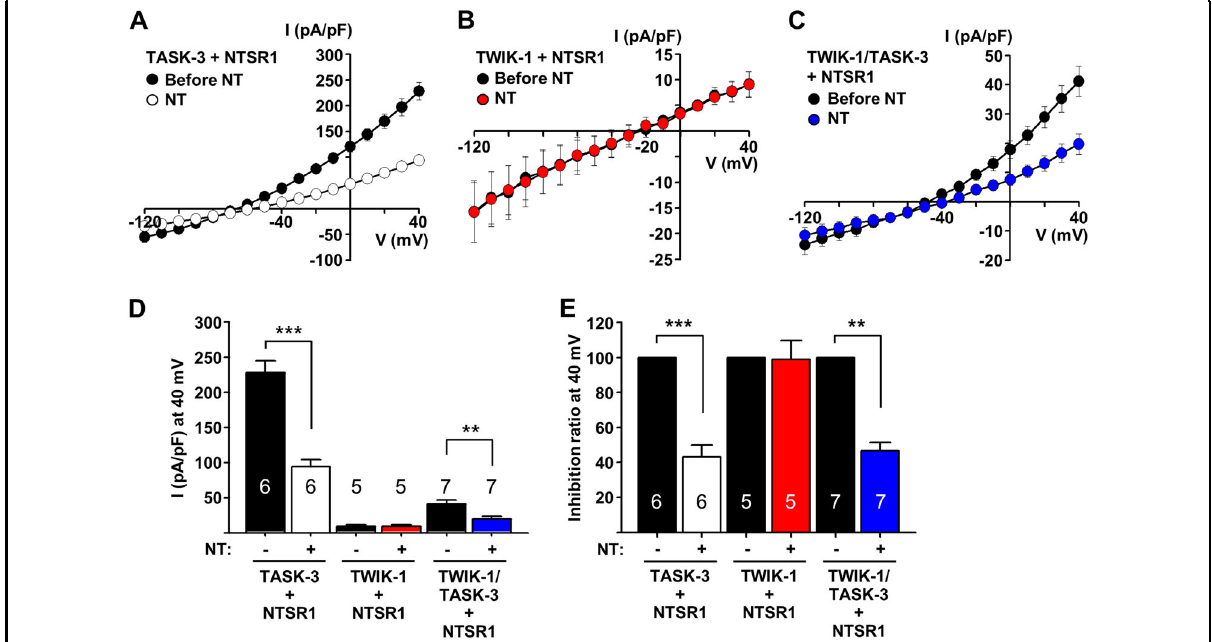
Fig. 5 The activity of the TWIK-1/TASK-3 concatenated chimera is inhibited by NT – NTSR1 signaling. a – c Averaged I – V relationships in COS-7 cells transfected with TASK-3 and NTSR1 a , TWIK-1 and NTSR1 b , or the TASK-3/TWIK-1 concatenated channel and NTSR1 c , measured before and after the application of 10 μ M neurotensin (NT) under a whole-cell con fi guration. d Summary bar graph showing normalized current density (as in a – c ) at + 40 mV. All values are means ± SEM (** P < 0.01 and *** P < 0.001). e Summary bar graph showing the inhibition ratio by NT application. All values are means ± SEM (** P < 0.01 and *** P < 0.001). The P -values were obtained with Student ’ s t